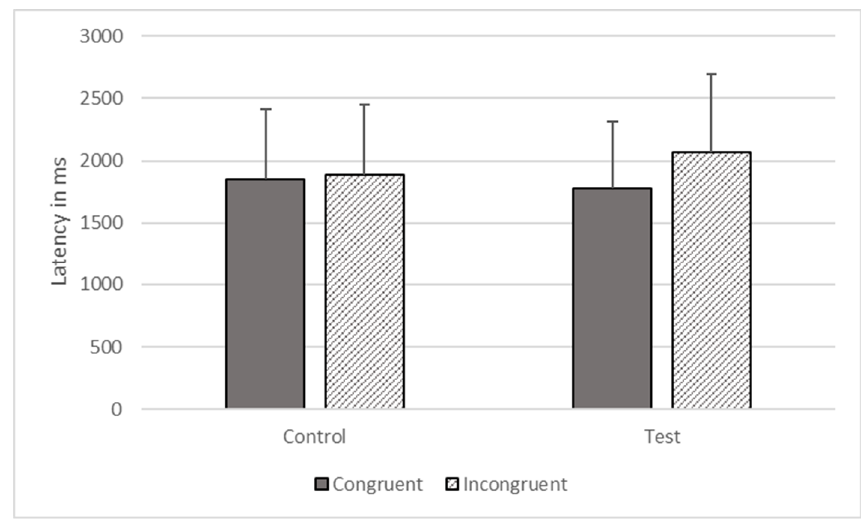
Figure 4. Response latencies as a function of trial types in Phase Three.